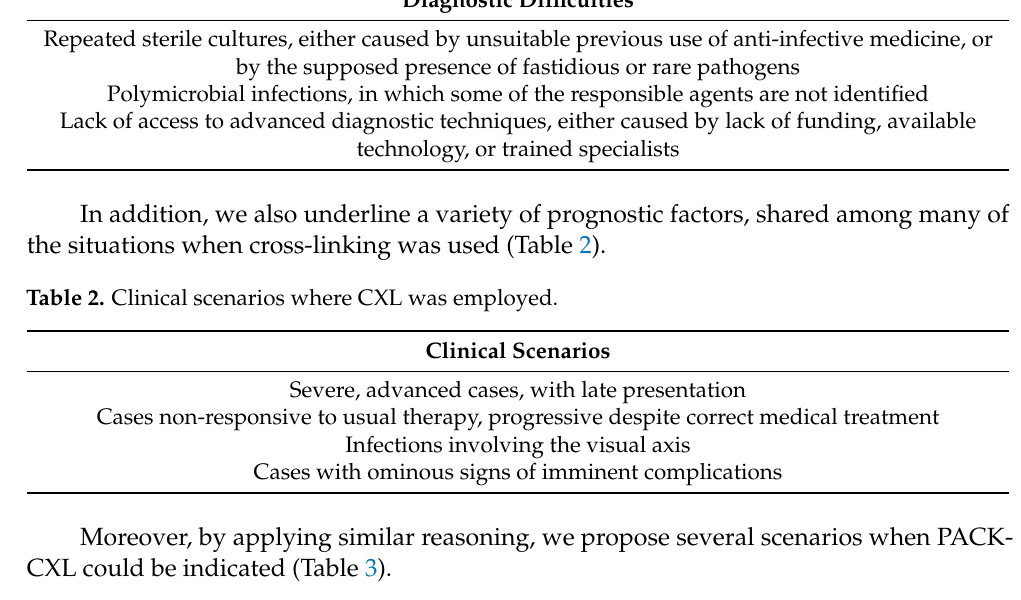
Table 3. Possible PACK-CXL